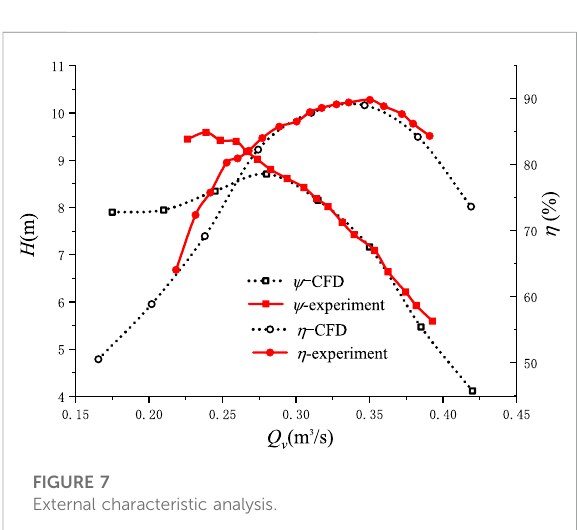
FIGURE 7 External characteristic